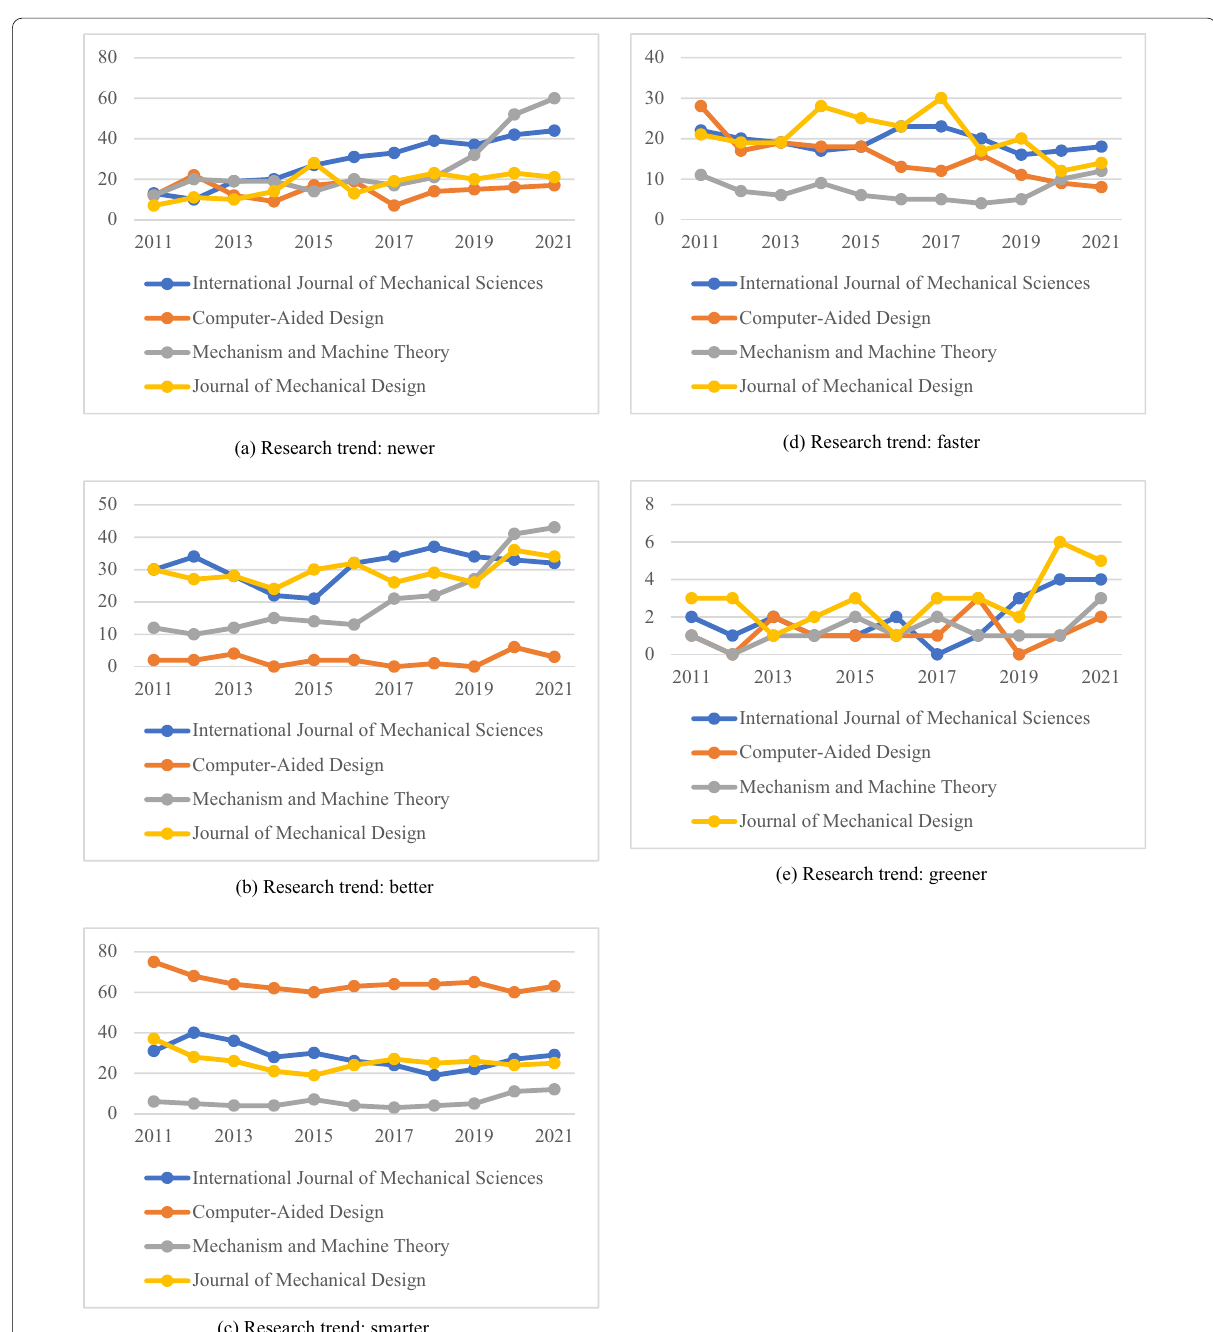
Figure 6 Statistical analysis of papers in authoritative international journals in the field of